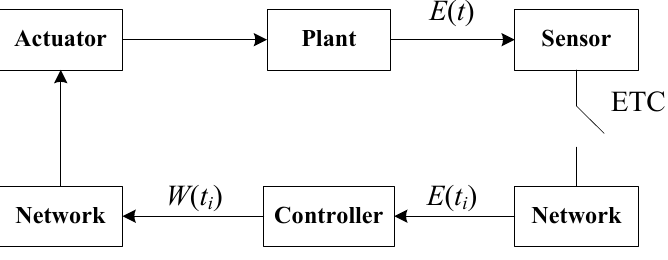
Figure 1. The block diagram of ETC